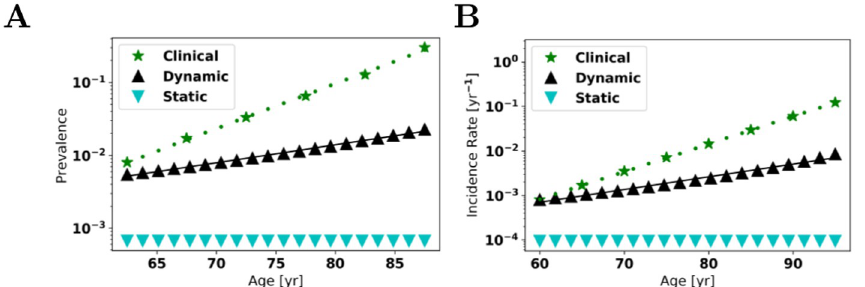
Fig 3. Incidence and prevalence. Comparison of static and dynamic models with clinical data for AD. The dotted green lines represent the line of best fit to clinical data [19, 34] on log-scale; The black solid lines are the lines of best fit to the dynamic model on log-scale. A : for prevalence, the clinical doubling time is 4.9 y and our dynamic model predicts 12 y. B : for incidence, the clinical doubling time is 4.9 y and our dynamic model predicts 11 y. The value γ is chosen so that clinical and dynamic model incidence agree at age